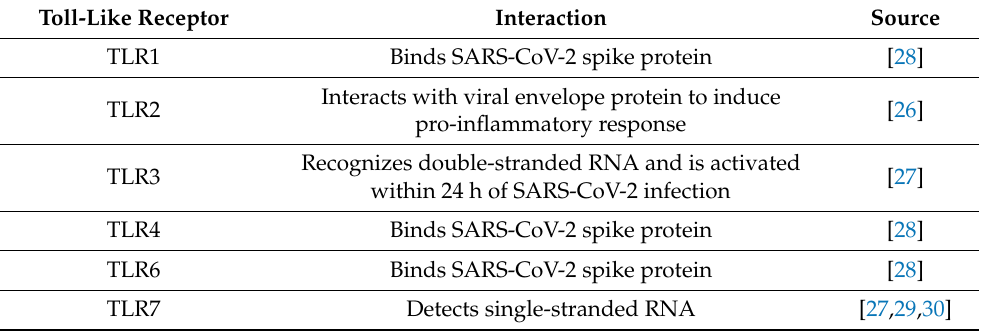
Table 2. TLR detection of